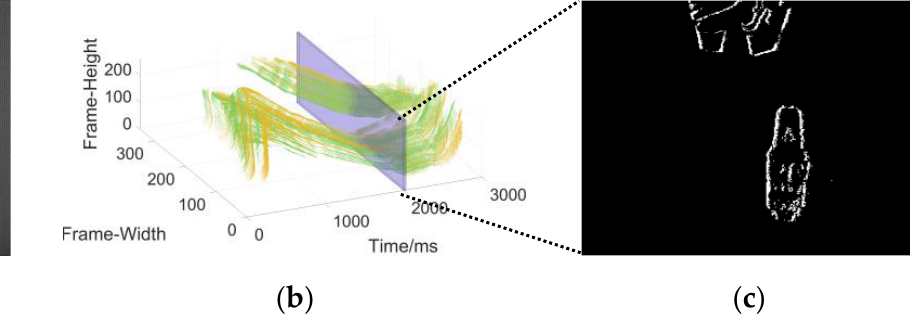
Figure 2. Illustration of DVS output and virtual frame. ( a ) Moving object of DVS observation; ( b ) the visualization of the event stream, DVS output is the event stream of address events ( x , y ) in time. Each address event signals that the pixel at that coordinate experienced a change of light at that instant. ( c ) The virtual frame constructed by the slice in ( b ).